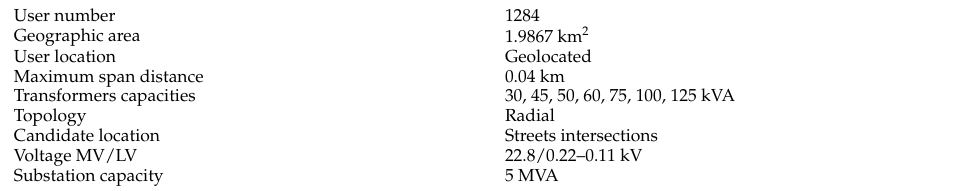
Table 3. Simulation